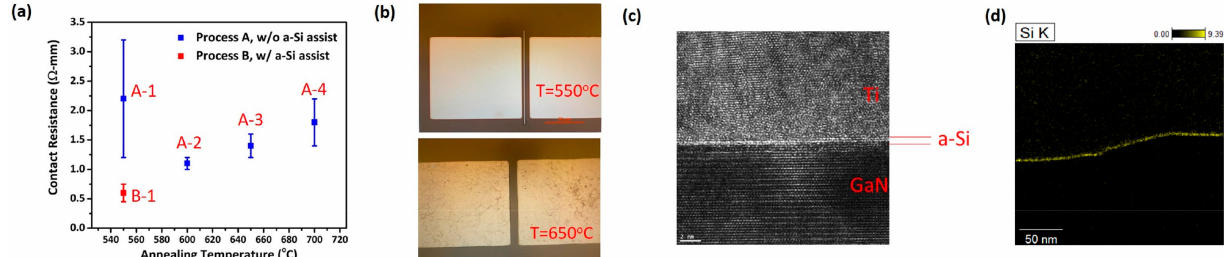
Figure 3. ( a ) Contact resistance as a function of annealing temperature. ( b ) The optical microscopy images of Sample A-1 and Sample A-3, Al boiling can be observed. ( c ) The HR-TEM image of the interface between Ti/GaN corresponds to a 1 nm a-Si-assisted layer of Sample B-1. ( d ) The EDS mapping of Si signal by TEM, the inset shows the corresponding TEM image.